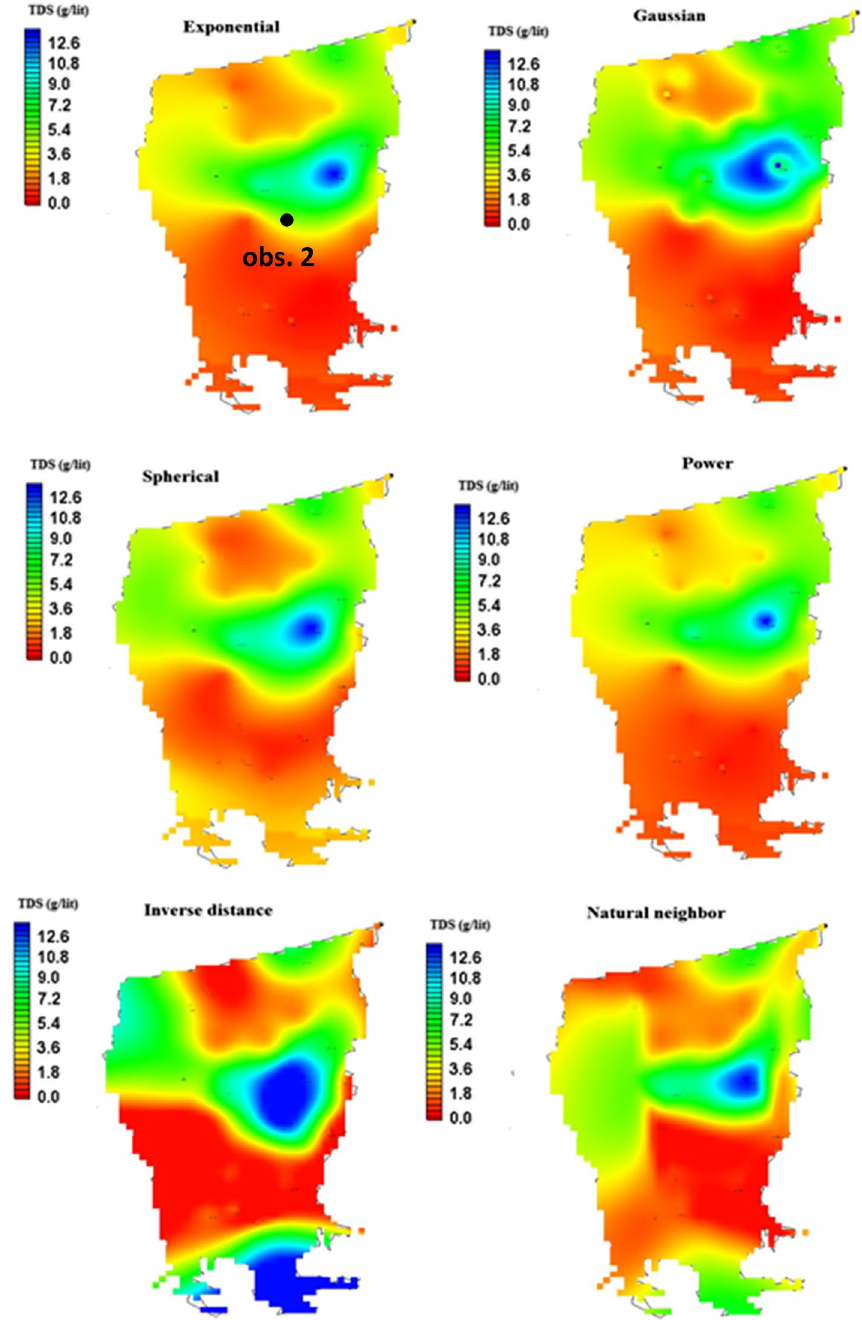
Fig. 7 Spatial distribution of TDS corresponding to different variogram